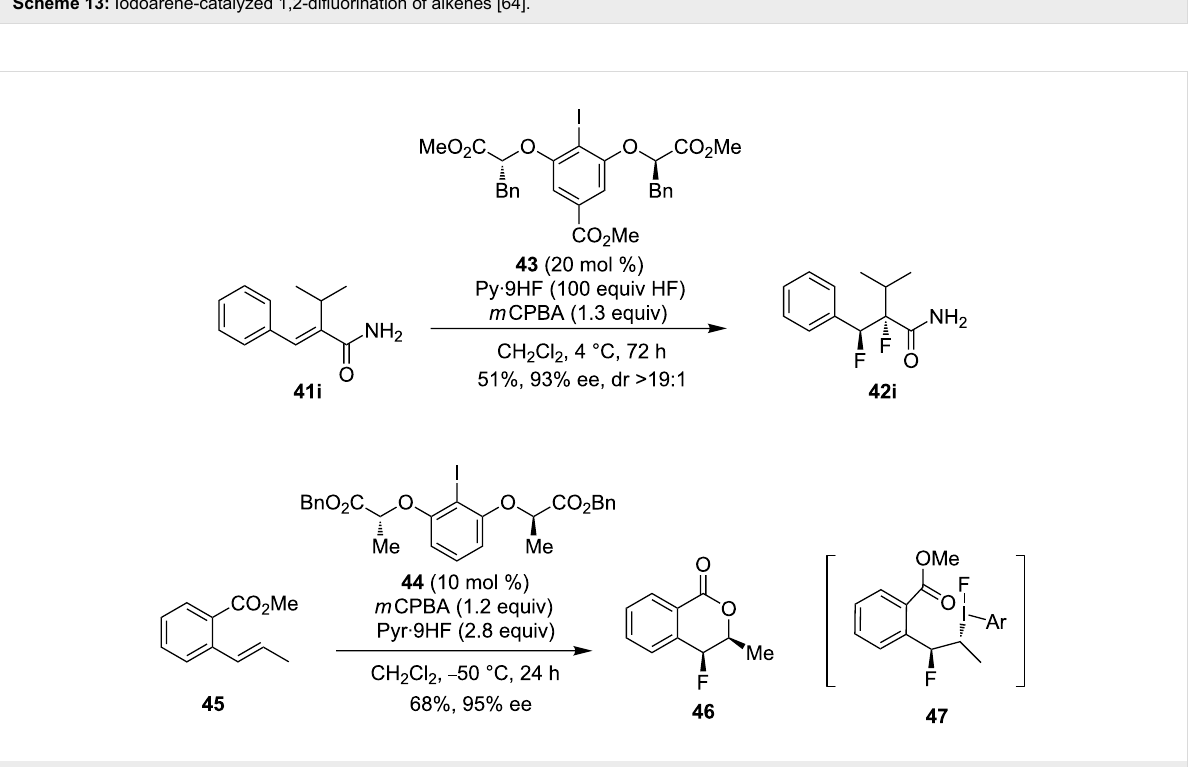
Scheme 14: Iodoarene-catalyzed asymmetric fluorination of styrenes [64,65].